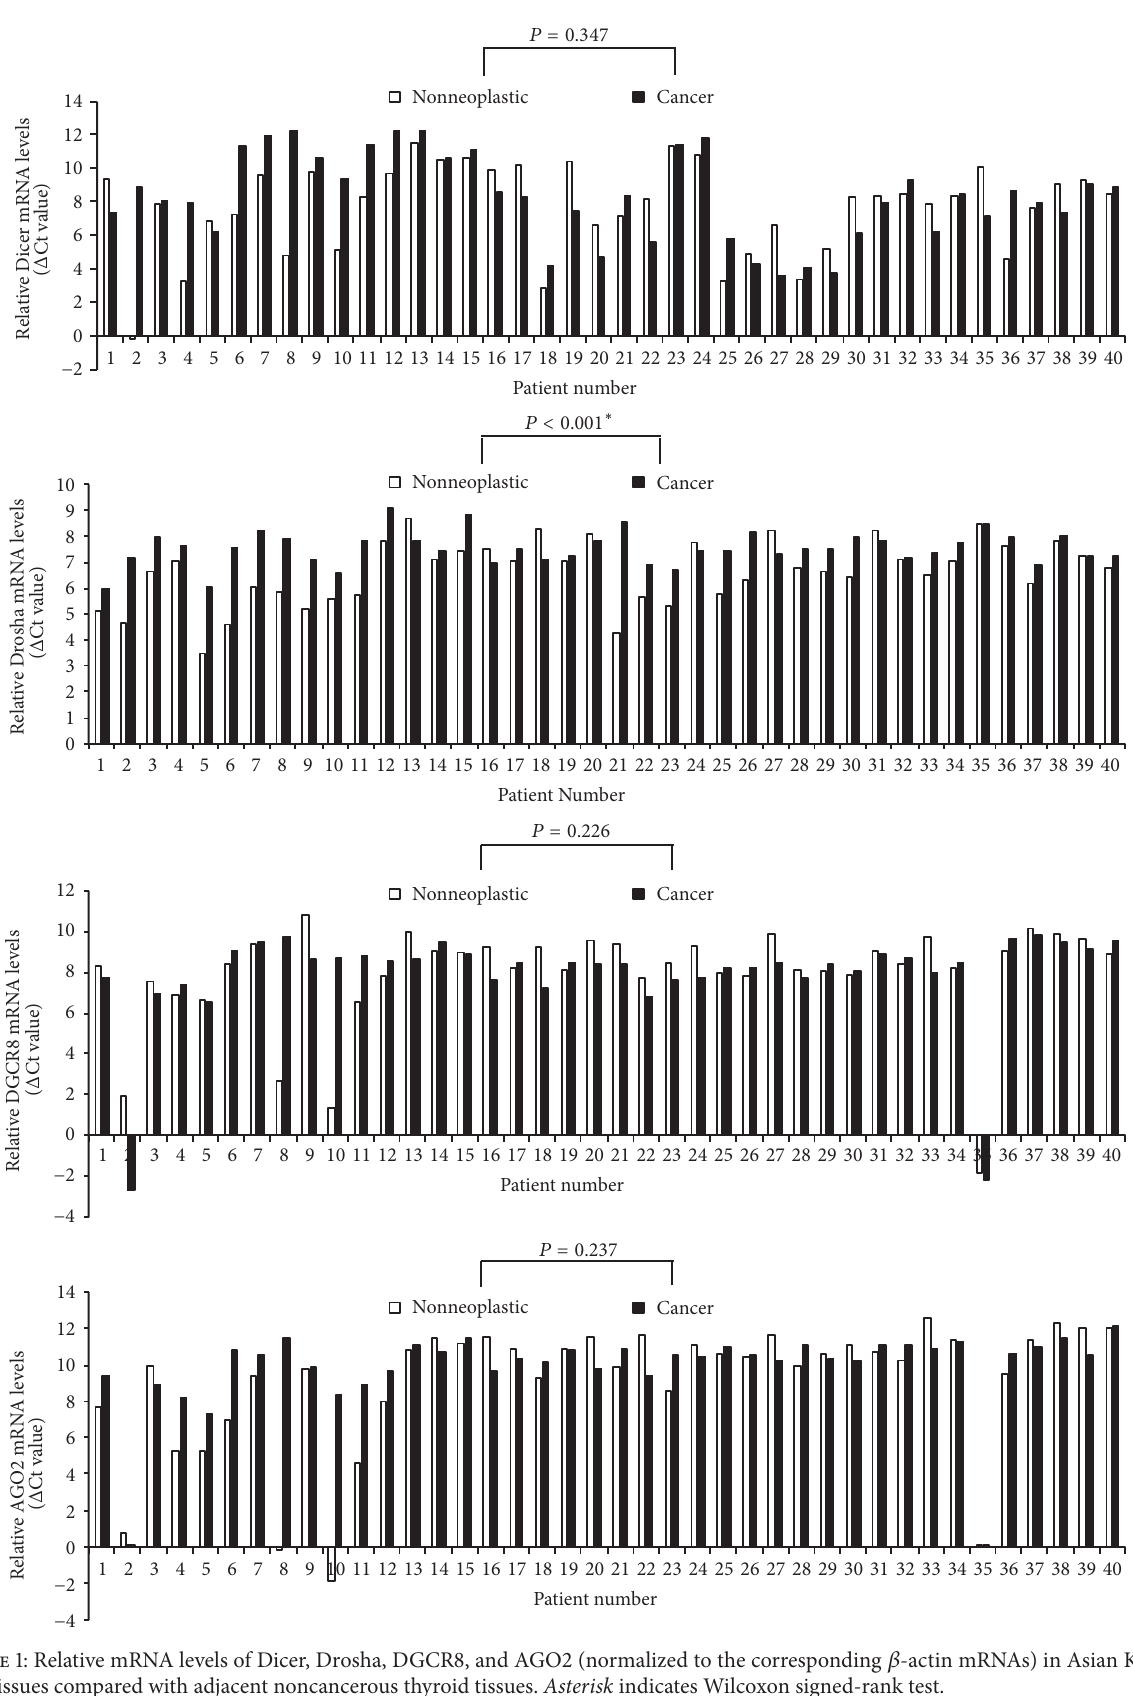
Figure 1: Relative mRNA levels of Dicer, Drosha, DGCR8, and AGO2 (normalized to the corresponding 𝛽 -actin mRNAs) in Asian Korean PTC tissues compared with adjacent noncancerous thyroid tissues. Asterisk indicates Wilcoxon signed-rank